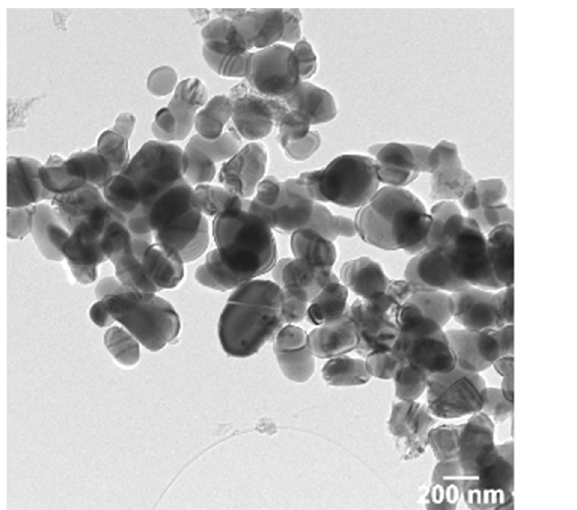
Figure 1. SEM image of the S2 (Ca-Cu/TiO 2 ) sample. The images of the coated TiO 2 microparticles were evidenced by transmission elec- tronic microscopy (TEM) (Figure 2).